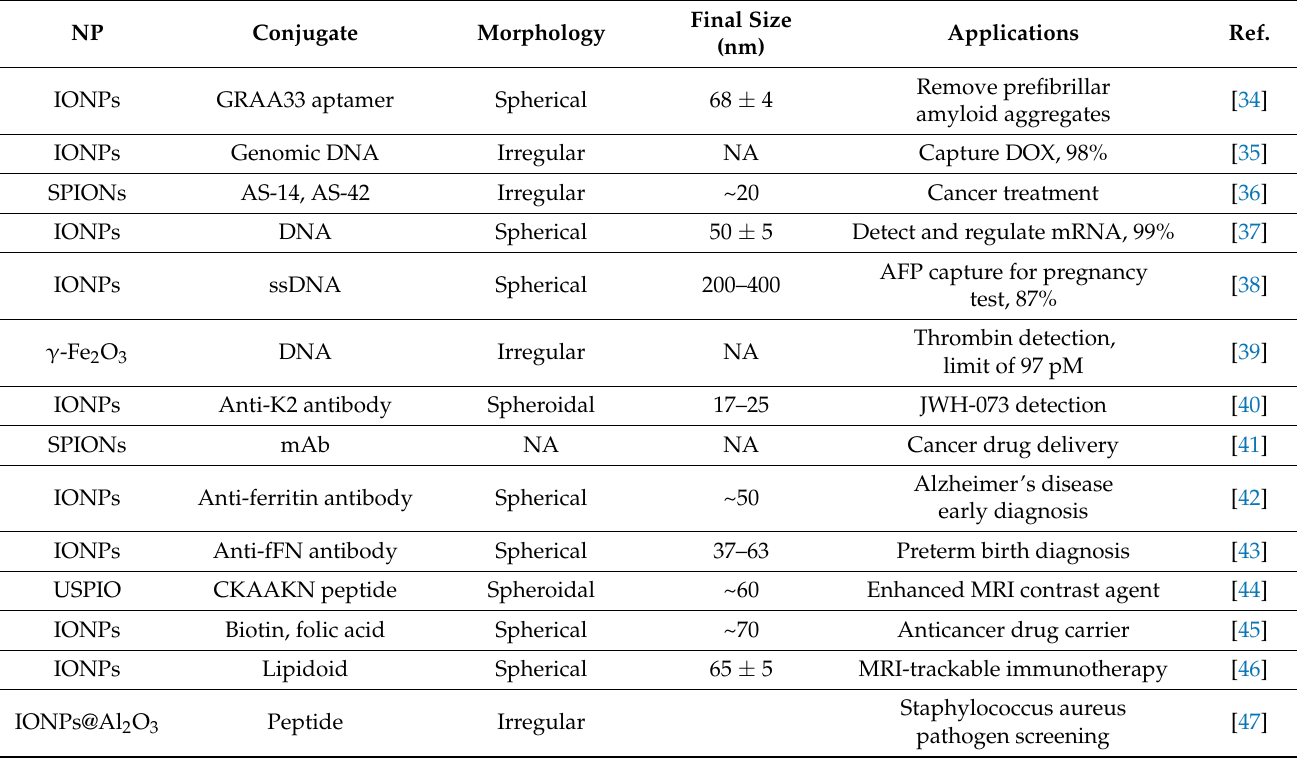
Table 2. Biomolecule-functionalized magnetic iron oxide nanoparticles for biomedical